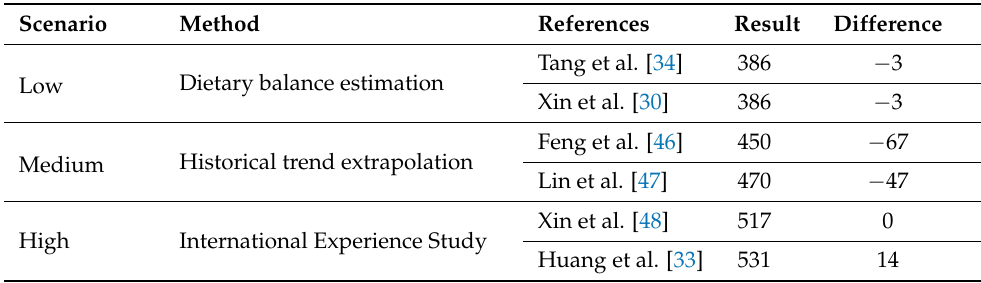
Table 1. Comparison with the results of existing studies. Scenario Method Low Dietary balance estimation